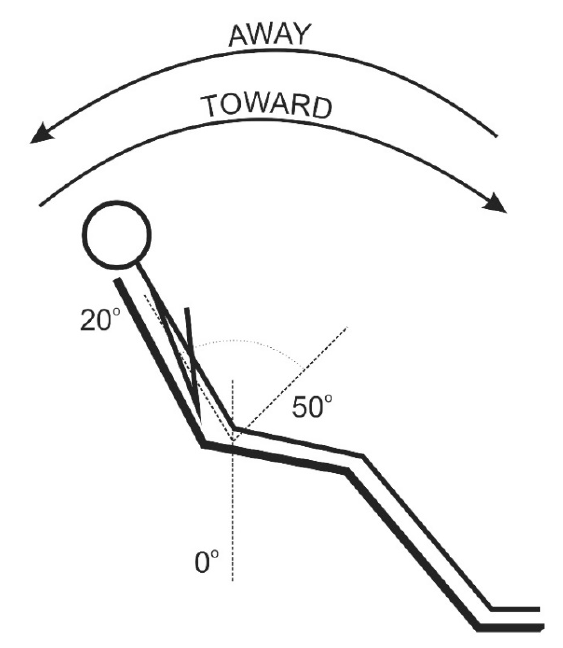
Figure 2. Isokinetic examination of the trunk muscles (semi-standing position).